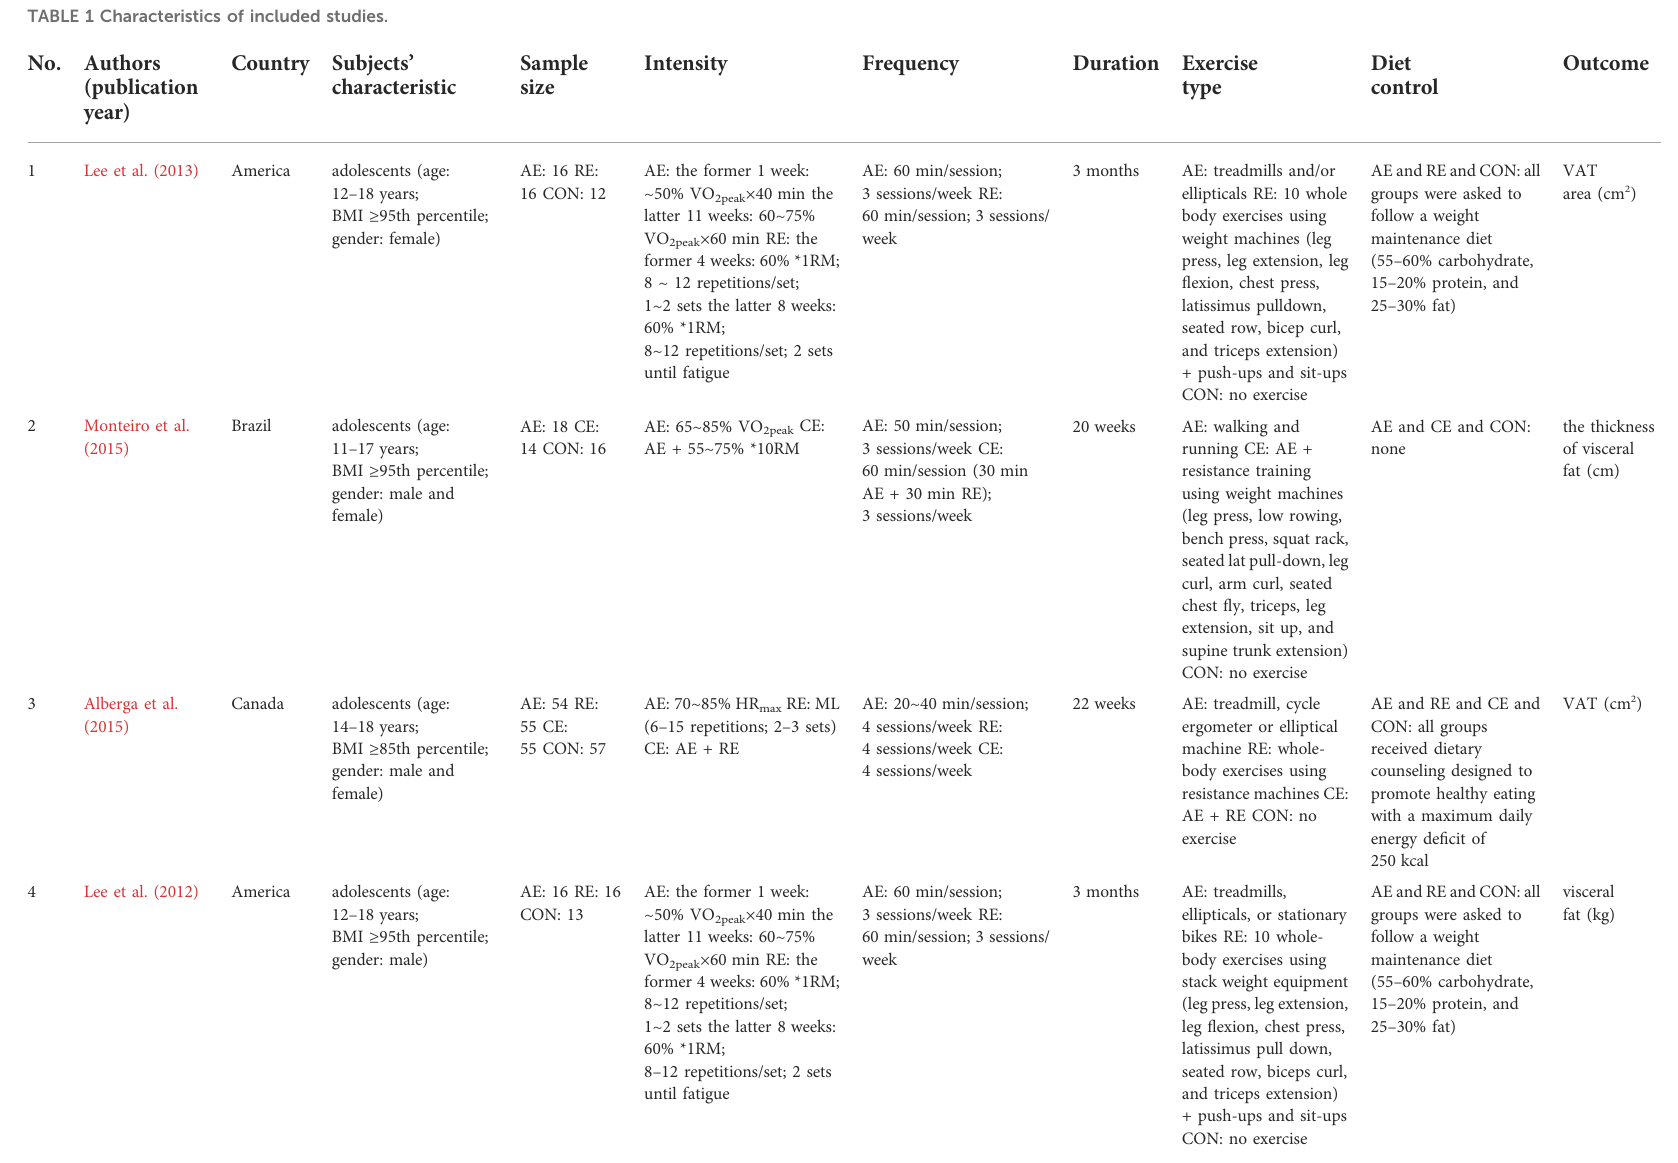
TABLE 1 Characteristics of included